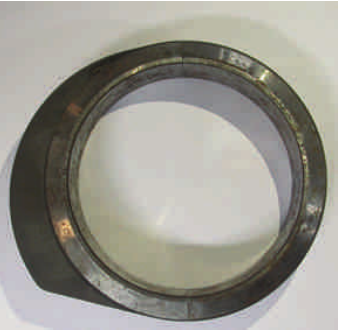
Fig. 5. The image the fuel cam of the inspected engine